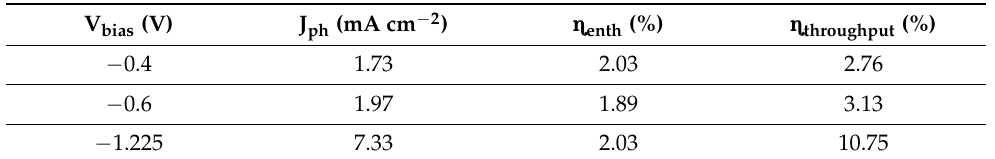
Figure 5. Enthalpy and throughput efficiency of PECs with photocathode co-catalyst loading: ( a ) bare PEC, ( b ) Ni (8 µg cm −2 ), ( c ) Ni (12 µg cm −2 ), and ( d ) NiCu (8 µg cm −2 ). Bias is reported as the cathode potential minus the anode potential. Table 1. Photocurrent density (J ph ), enthalpy efficiency ( ï enth ), and throughput efficiency ( ï throughput ) achieved by the addition of Ni co-catalyst to the